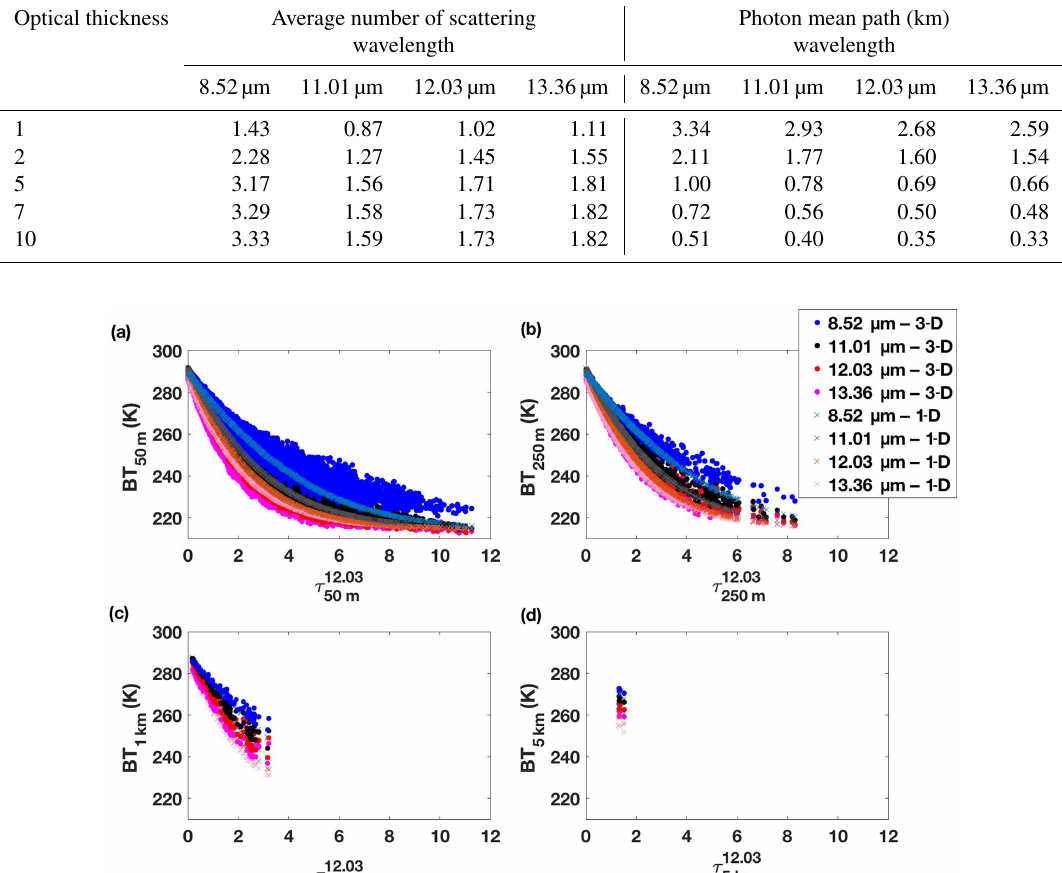
Figure 5. Brightness temperature (BT) as a function of the optical thickness at 12.03µm for MODIS channels centered at 8 . 52, 11 . 01, 12 . 03 and 13 . 36µm at spatial resolutions of 50m (a) , 250m (b) , 1km (c) and 5km (d)